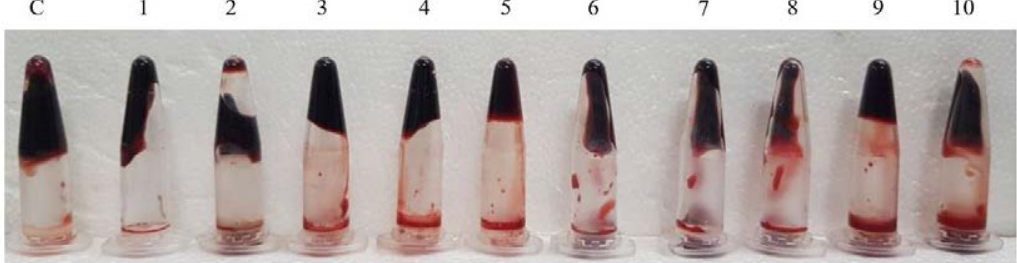
Fig. 5. Clot lysis assay for Serrapeptase. C: control (treated with water), 1-10: Serrapeptase enzyme treated from 10U/mLto 100